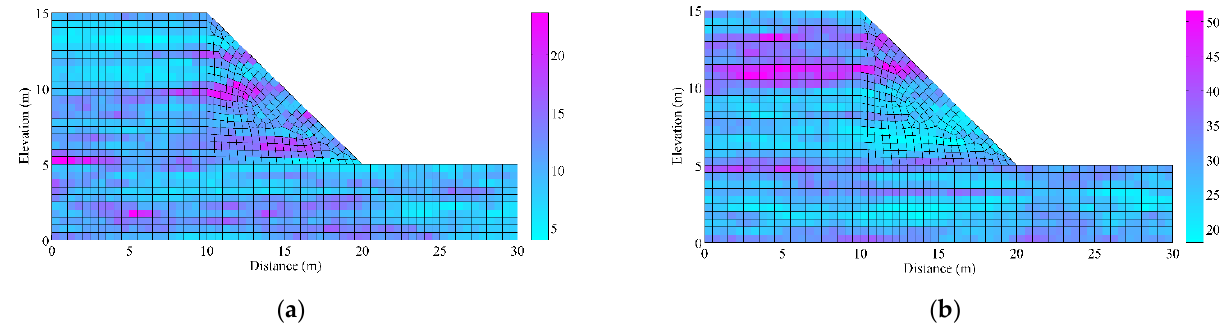
Figure 4. A typical realization of Gaussian copula-based transversely anisotropic CCRF. ( a ) Random field of c. ( b ) Random field of φ .